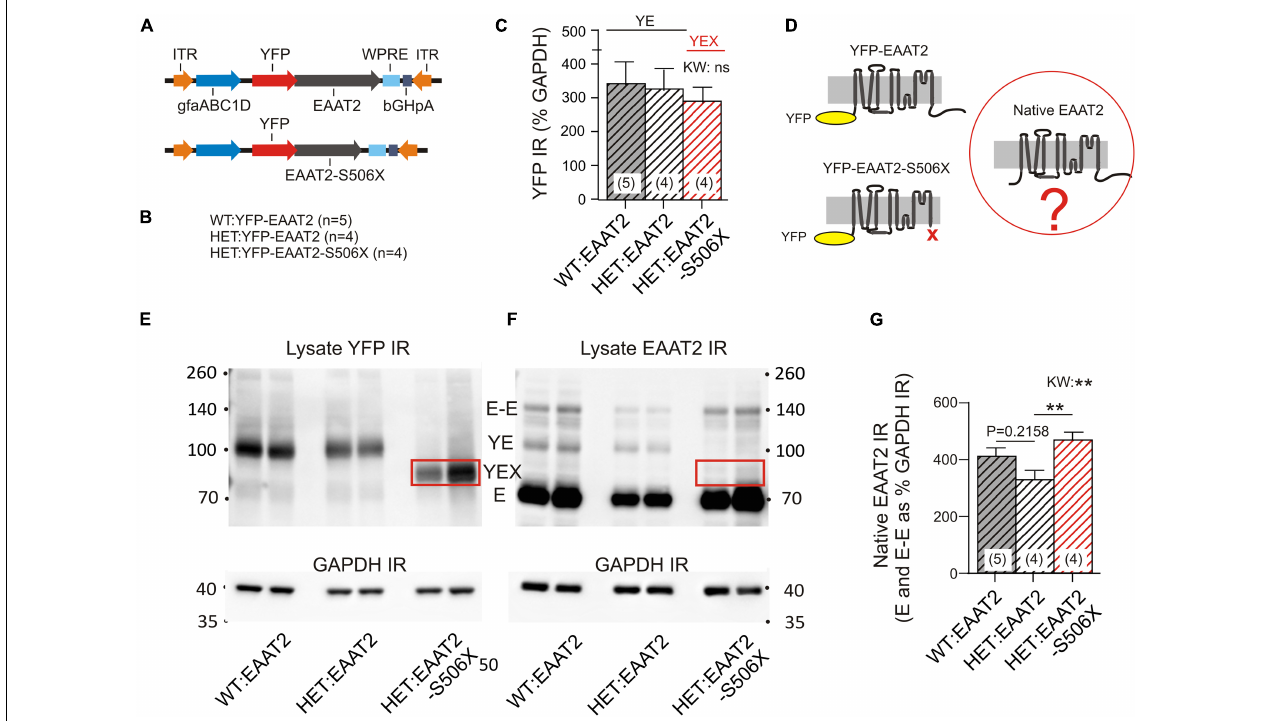
FIGURE 3 | Effects of mHTT and S506X on the native murine EAAT2. (A) Injected vectors. (B) Animal groups. (C) Same amounts of YFP IR in the 3 samples. (D) Three principal variants of EAAT2 to be detected by in the lysates. (E,F) WB samples for quantification of YFP and EAAT2 IR in striatal lysates. At least four animals per group (shown are two). The boxed band YEX is not detected in (F) since the preferred antibody against EAAT2 binds to a region located on the deleted C-terminal. For the abbreviations see Figure 2D . (G) Mean intensity of native EAAT2 IR (mono- and dimers). Note increase of native EAAT2 level in HET:EAAT2-S506Xs. Non-parametric Kruskal–Wallis test (KW) and Dunn’s post hoc comparison. ** p < 0.01.